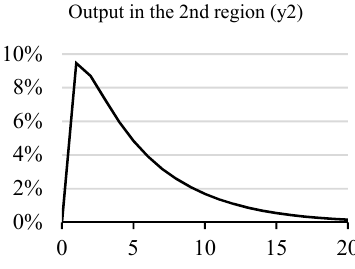
Figure 8. Output growth in the second region. A positive output gap in the second region triggers the following chain of budget effects—tax revenues increase, which proportionally increases both current budget pur- chases and human capital expenditures (Figure 9). The growth of current budget purchases reinforces the positive output gap. Moreover, the growth of human capital expenditures raises the aggregate factor productivity (Figure